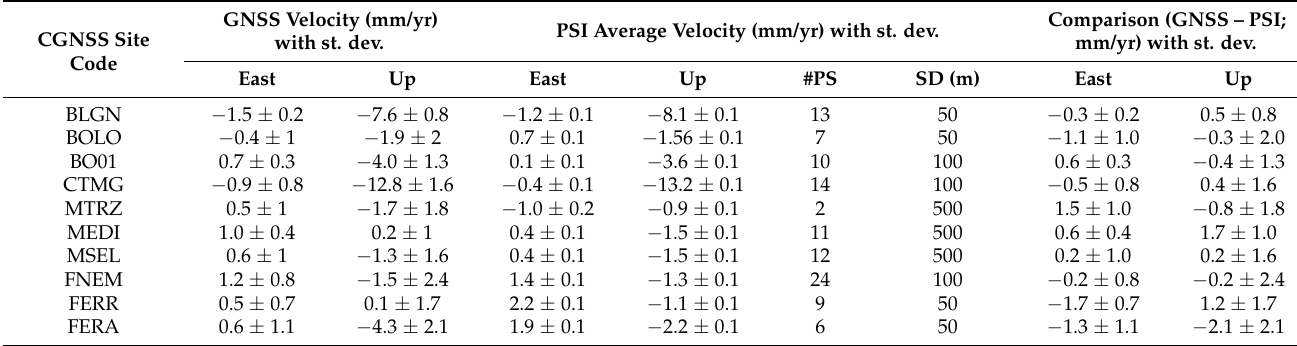
Table 2. Results of the comparisons between the velocities at the GNSS sites and the average persistent scatterer interferom- etry velocities for a minimum set of five persistent scatterers located around the CGNSS site at a distance ≤ 500 m. GNSS Velocity (mm/yr) PSI Average Velocity (mm/yr) with st. CGNSS Site with st. dev. Code